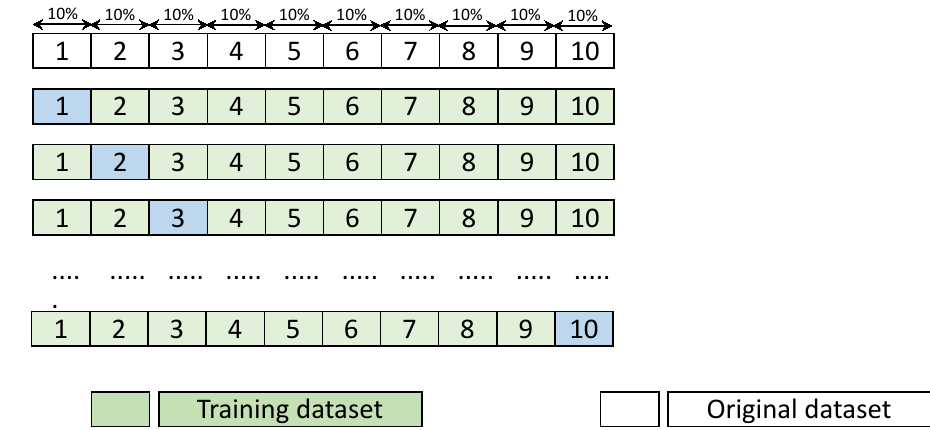
Figure 4. Evaluation of the modeling techniques performance of MLR, RF, and MARS, using the 10-fold cross validation scheme.